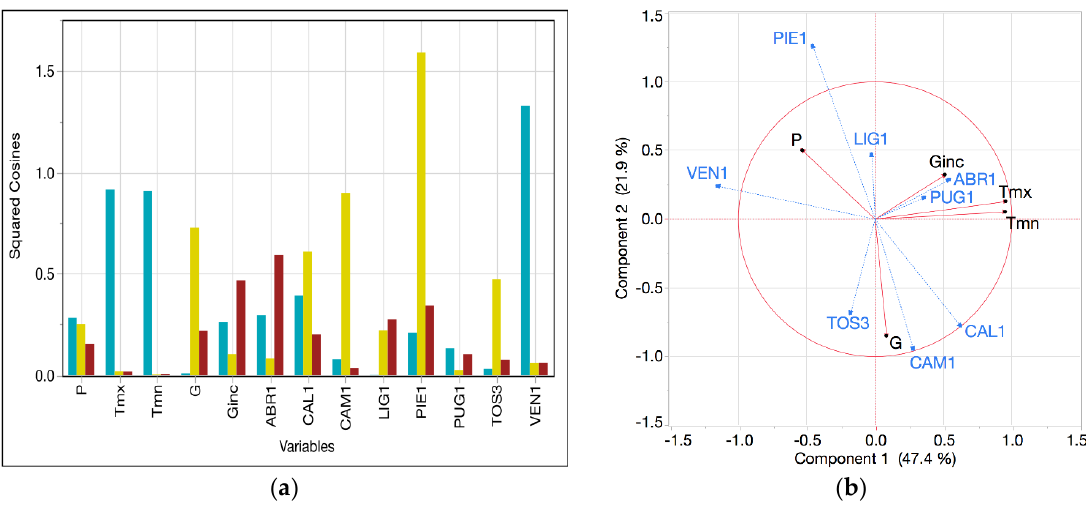
Figure 3. Results of a Principal Component Analysis. ( a ) variables squared cosines for the first two principal components. ( a : climatic and dendrometers’ variables; b : sites). ( b ) variable loadings for the first two principal components. Supplementary variables are shown in blue and dashed lines.